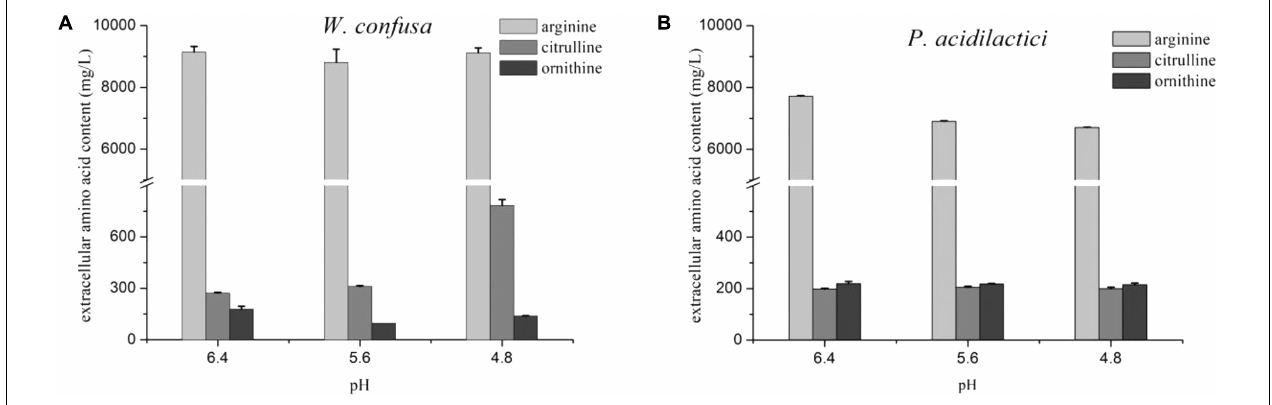
FIGURE 4 | The effect of pH on arginine metabolism of W. confusa (A) and P. acidilactici (B) in the presence of 18%